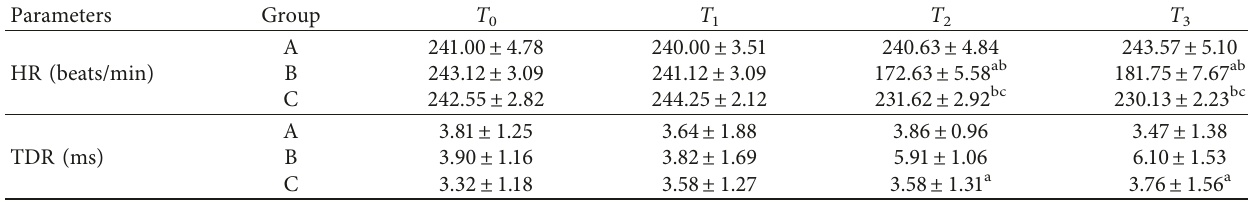
Table 1: Effects of sevoflurane on heart rate (HR) and transmural dispersion of repolarization (TDR) in I/R rats ( n � 8, x ± s ). Parameters Group